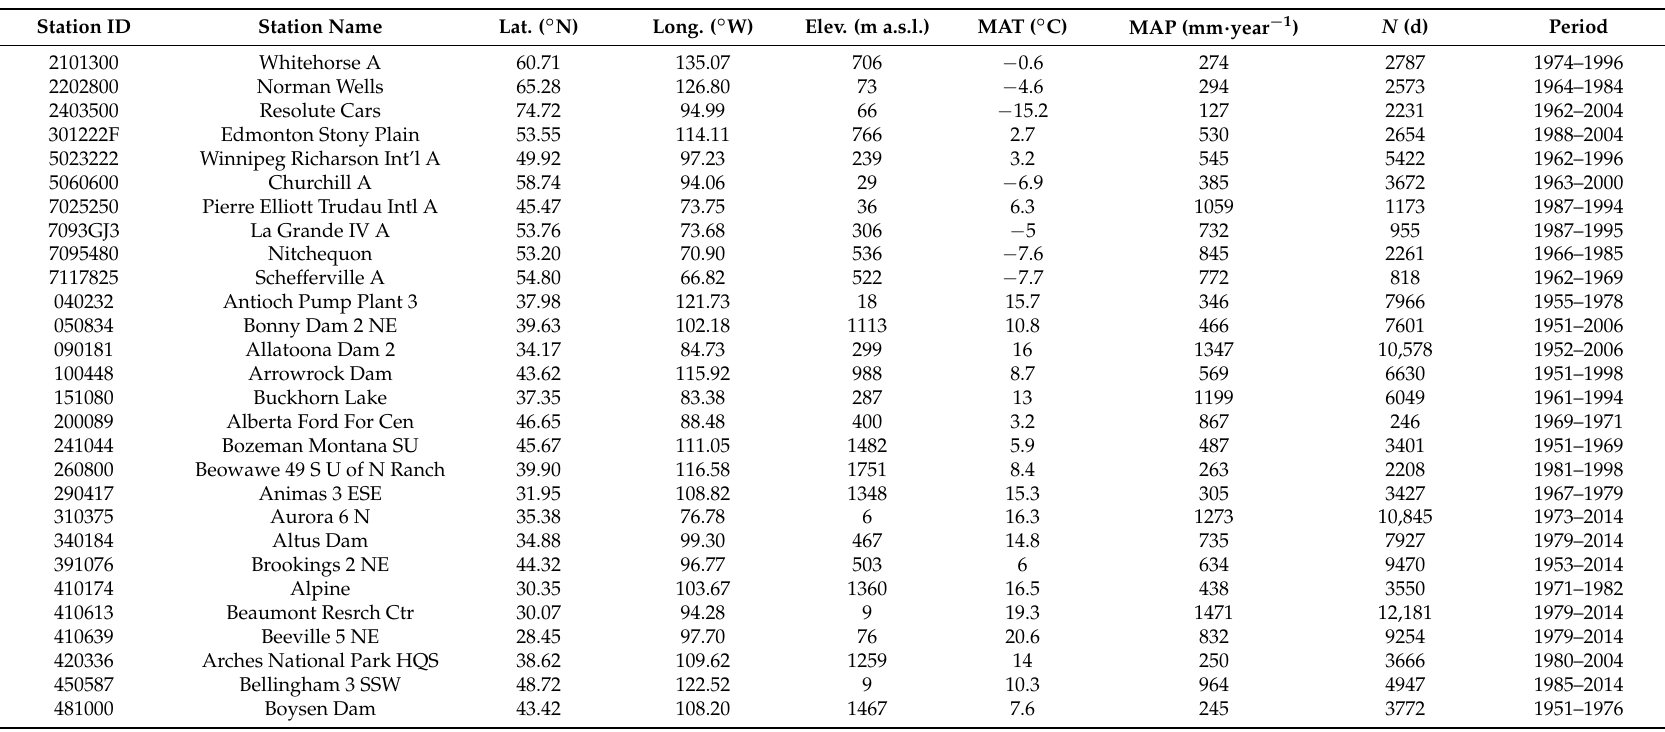
Table 1. Station information: Identifiers (ID) from Environment Canada or NOAA, geographic coordinates, mean annual temperature (MAT) and mean annual precipitation (MAP) for the 1971–2000 base period, number of days with measurements of pan evaporation ( E Pan ) used in the analysis ( n ), and time period of containing E Pan